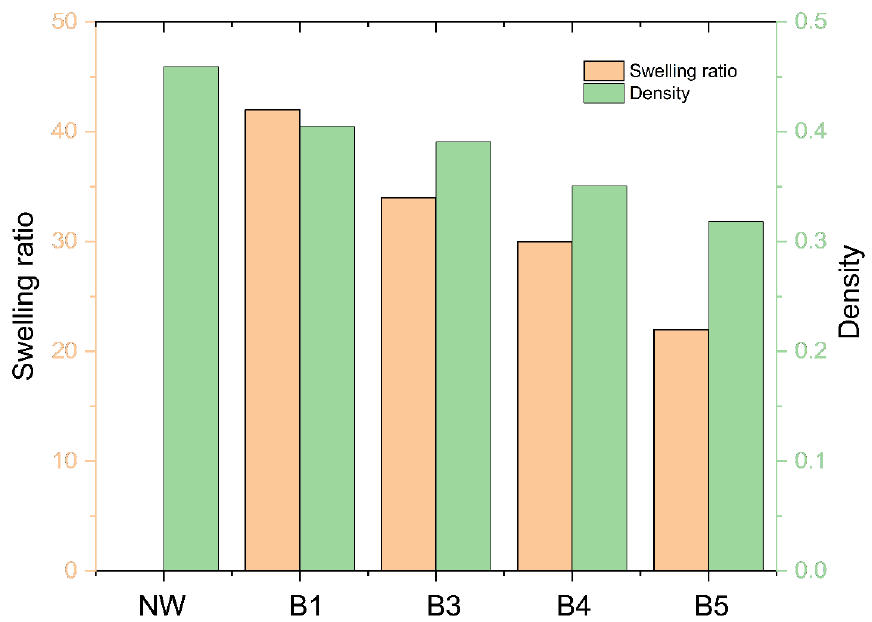
Figure 9. The swelling ratio of CW specimens and density change with bleaching steps. Table 2. Density changes of specimens under various bleaching steps and hot-pressing